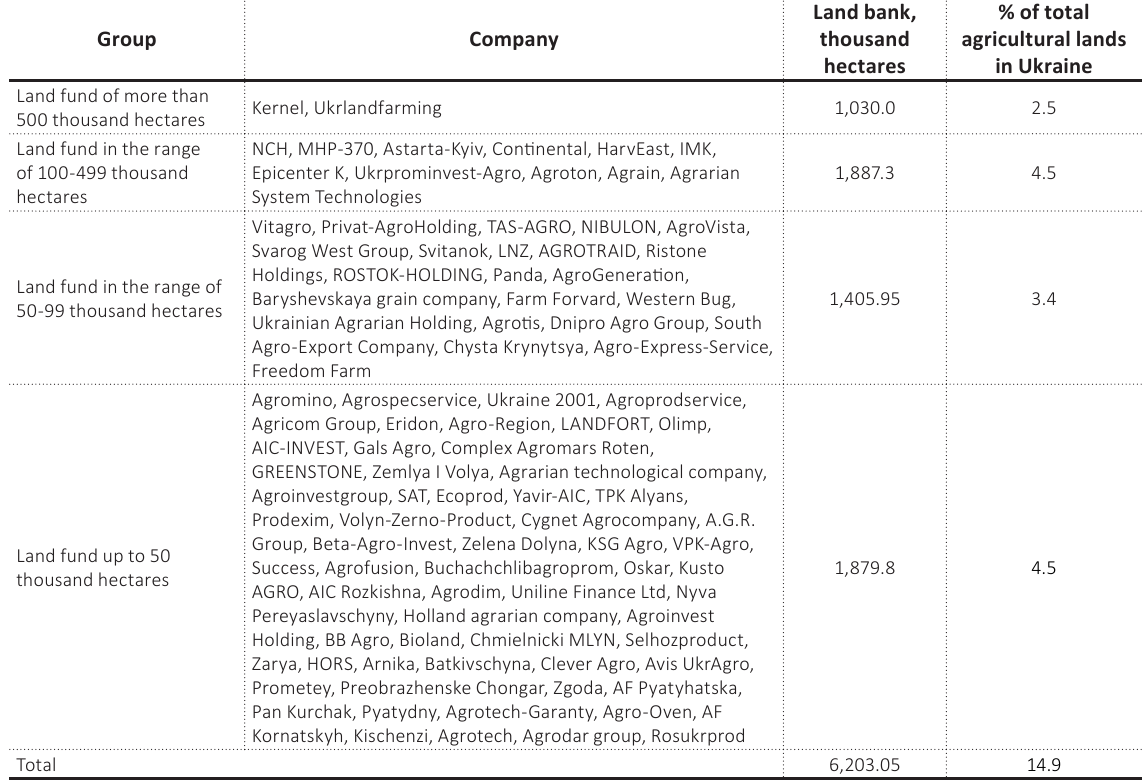
Source: Compiled by the authors using the data from